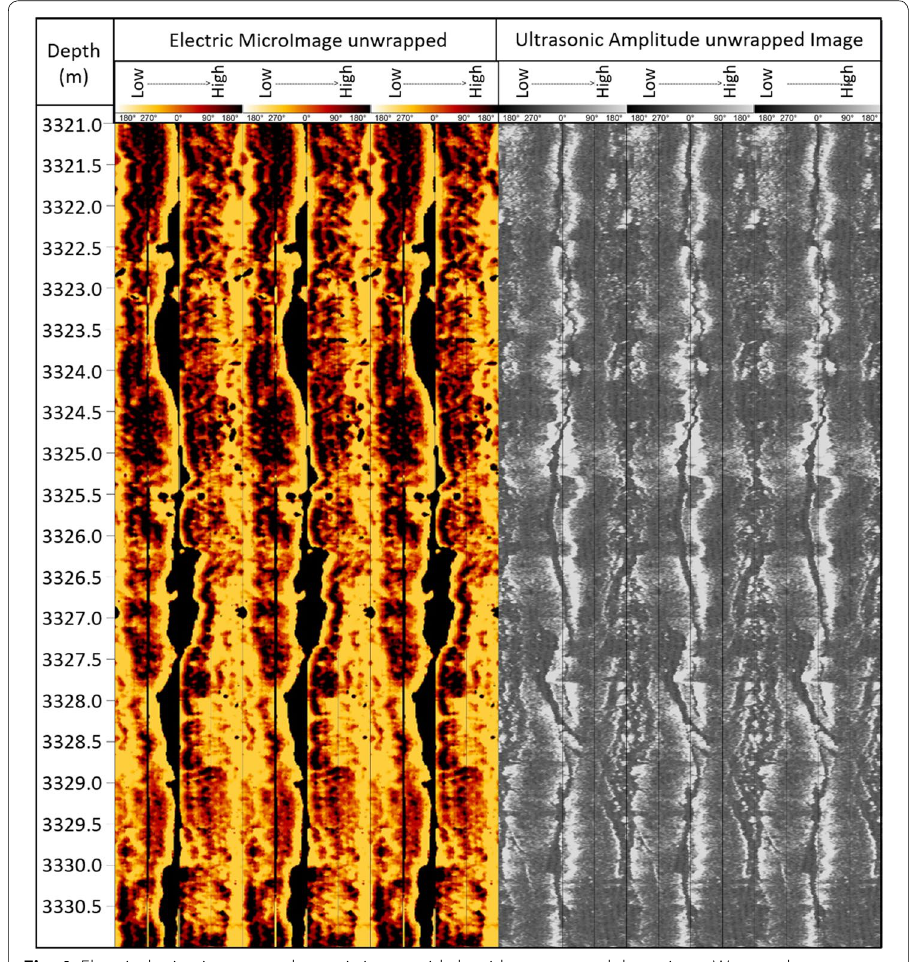
Fig. 4 Electrical microimage vs. ultrasonic image, side by side unwrapped three times. We can observe aggressive damage of the borehole in the ultrasonic image with variation of vertical drilling‑induced breakout on both aperture and shape along the borehole. The electrical microimage presents larger aperture on breakout and inverted behavior on azimuthal opposite breakouts (courtesy of Equinor and HS